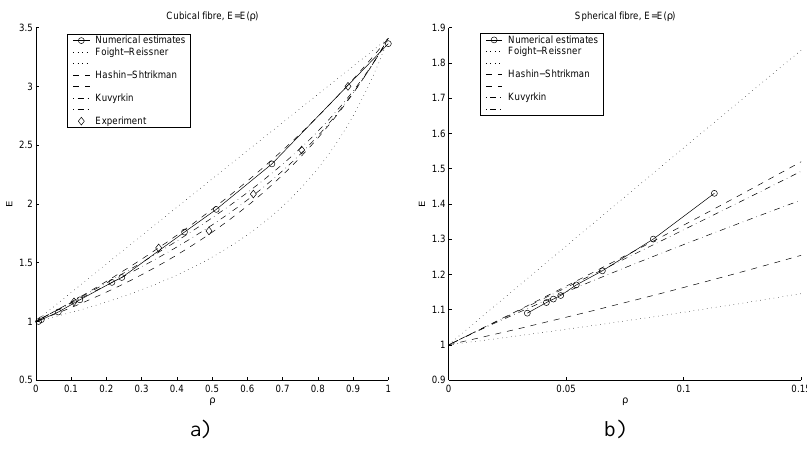
Figure 1. Experimental and simulated Young modulii: a) all SE are cubes, b) composite with Al matrix and spherical SiC